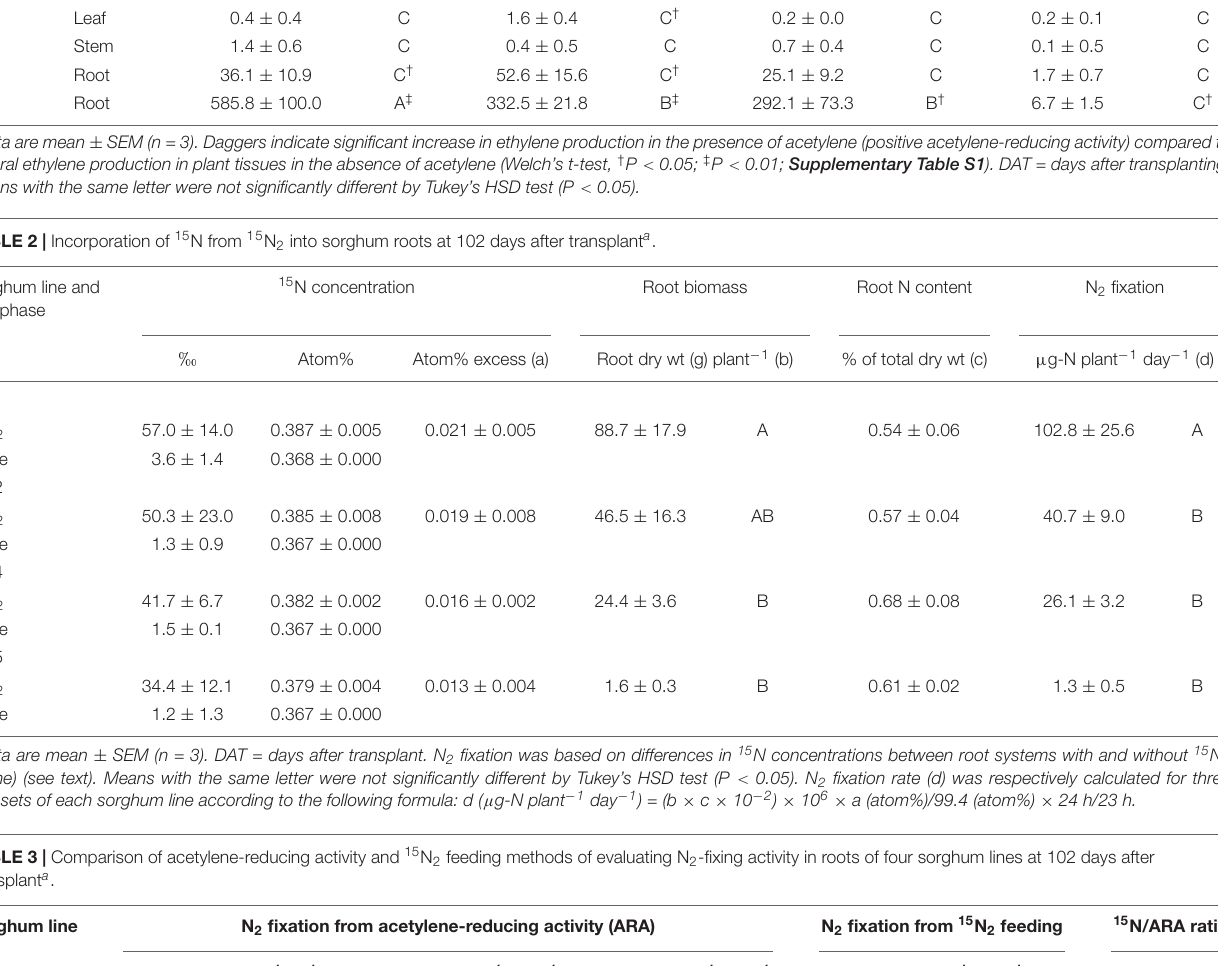
TABLE 3 | Comparison of acetylene-reducing activity and 15 N 2 feeding methods of evaluating N 2 -fixing activity in roots of four sorghum lines at 102 days after transplant a . Sorghum line N 2 fixation from acetylene-reducing activity (ARA)